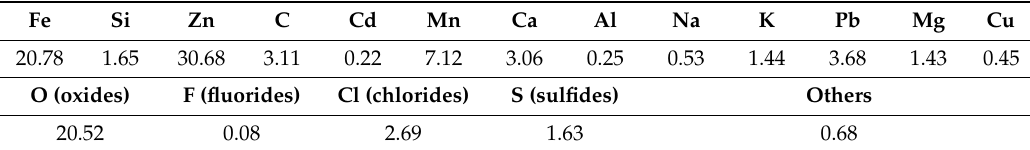
Table 2. EAF dust chemical composition, in wt. %.